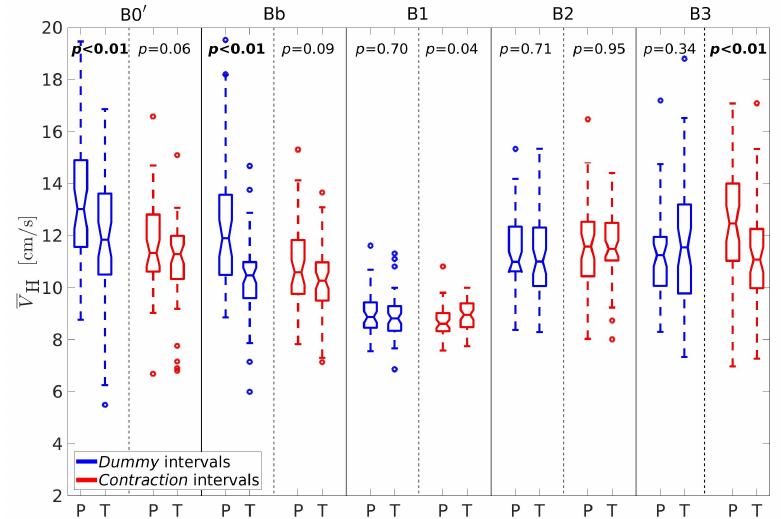
Figure 8. Box plots of the average conduction velocity amplitudes in the horizontal direction, V H . P—preterm intervals, T—term